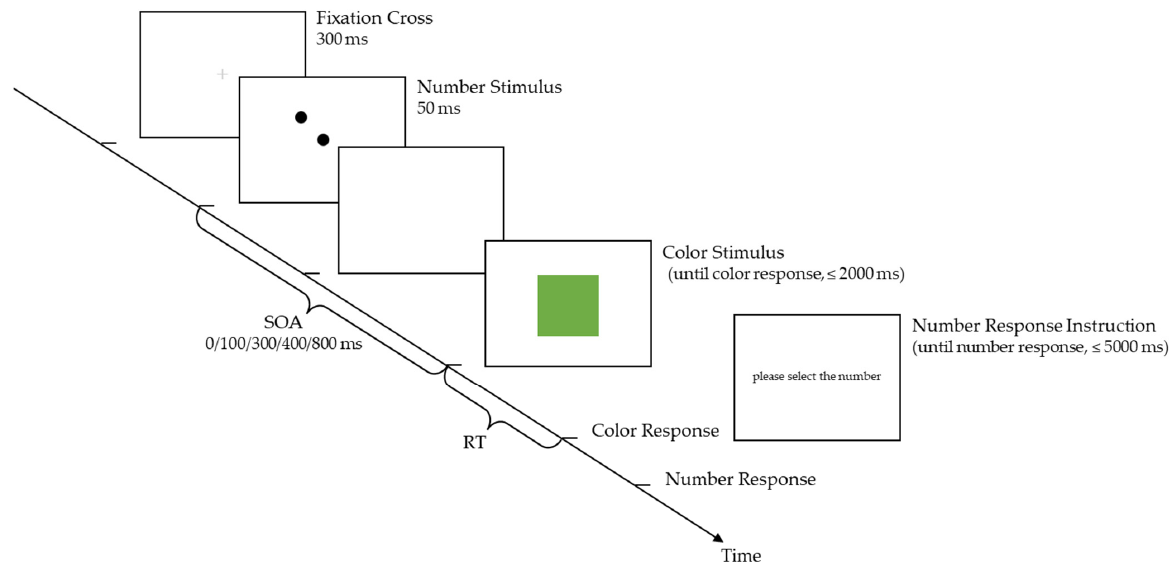
Figure 2. Schematic diagram of a main experiment trial. Within a block, identical trials (i.e., trials with same condition and number) were re- peated 3 times. Thus, each block contained 30 (conditions) × 2 (numbers) × 3 (repetition) = 180 trials. These trials were randomized. In total, the experiment contained 8 × 180 = 1440 trials.